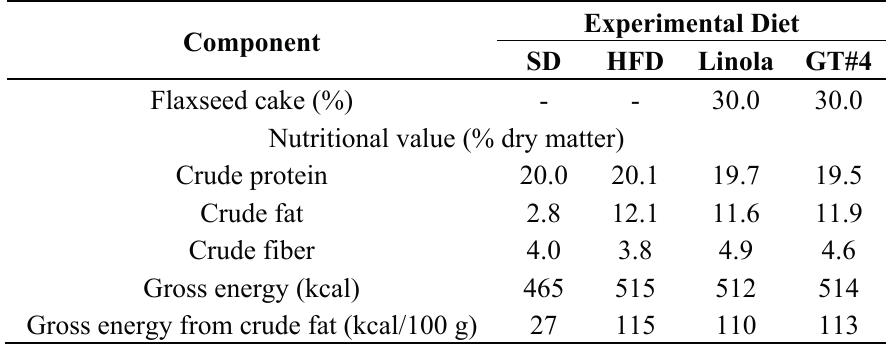
Table 1. Composition of diets and their nutritional